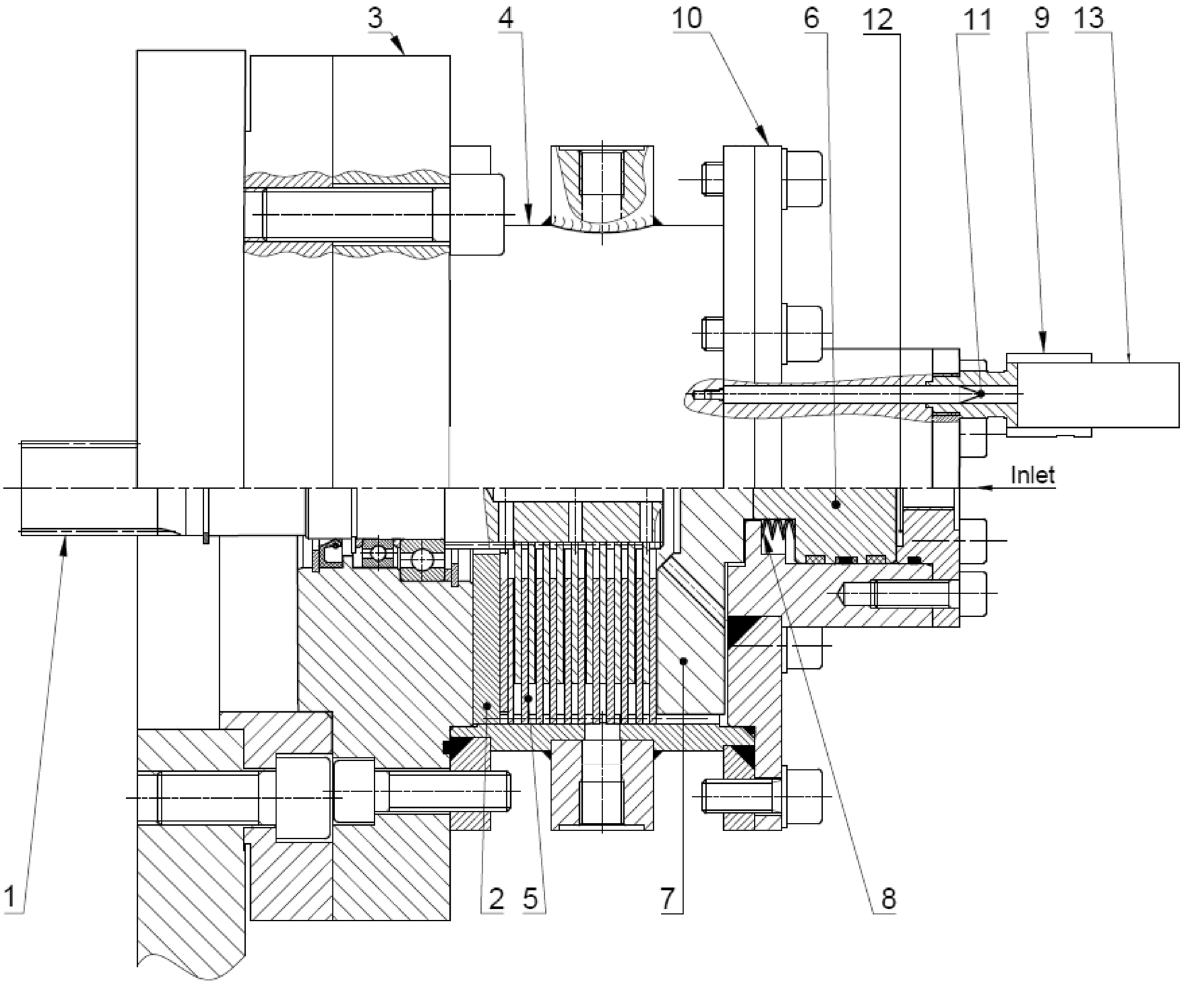
Figure 6. Half section view of multidisc wet clutch testing device 13,20 : 1—shaft, 2—blocking plate, 3—cover, 4—hub (housing), 5—friction and separator discs, 6—piston, 7—pressure plate, 8—package of disc springs, 9—position sensor holder, 10—cover, 11—position sensor tappet, 12—hydraulic actuator chamber, 13— displacement